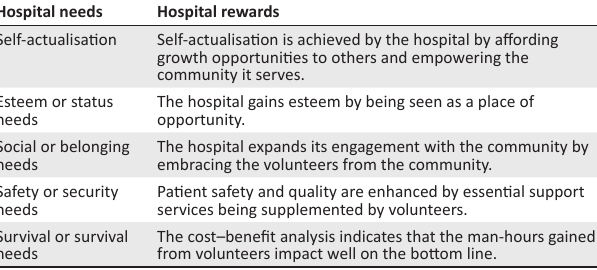
TABLE 2: Maslow’s motivational theory as applied to the hospital’s